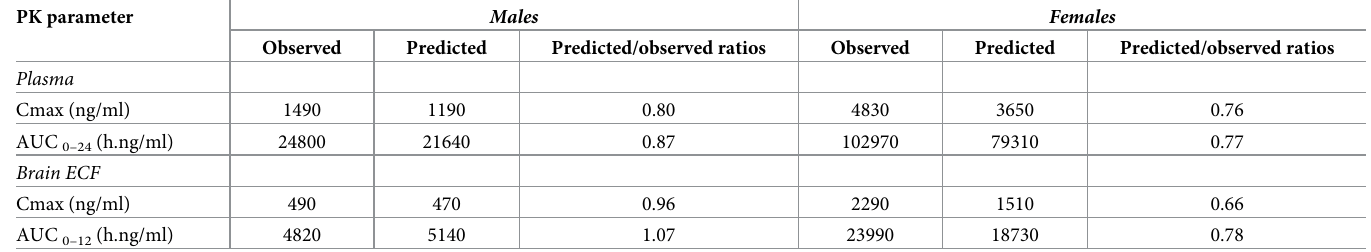
Table 5. Observed versus predicted steady state brain and plasma pharmacokinetic parameters of letrozole in both male and female rats following administration of 4 mg/kg dose for 5 (males) or 11 (females) consecutive days derived by NCA. PK